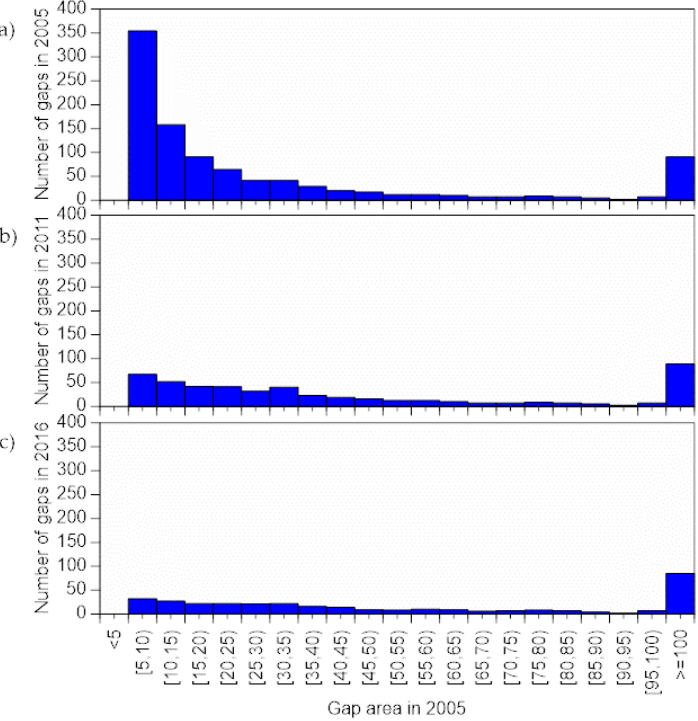
Figure 8. Changes in number of gaps existed in 2005. ( a ) Numbers in 2005, ( b ) 2011, and ( c ) 2016. Gap shrinkage is caused by height increase of understory vegetation which are young deciduous broadleaf trees in gaps and by lateral growth of surrounding trees. We analyzed how gap shrinkage caused by each of these factors affected the gap area (GAP2005, m 2 ) (Figure 9). The regression line for growth of understory vegetation ( Lc , m 2 ) relative to GAP2005 was as follows: The coefficient of determination was 0.472 ( p < 0.001). The regression line for lateral growth area ( Hc , m 2 ) relative to GAP2005 was as follows: